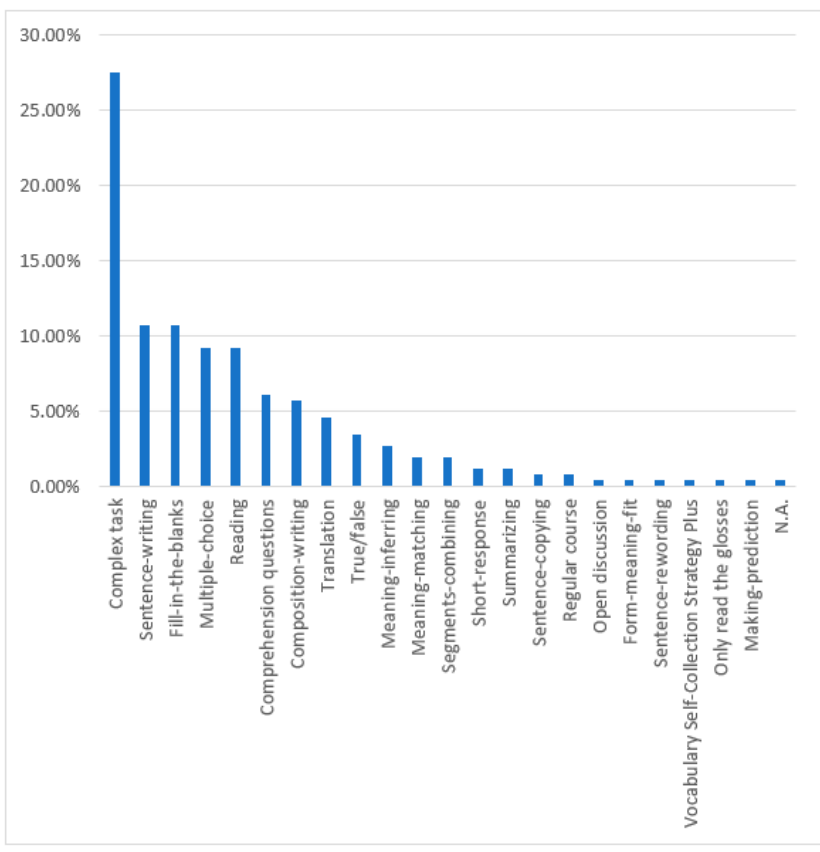
Figure 8. Tasks per study.